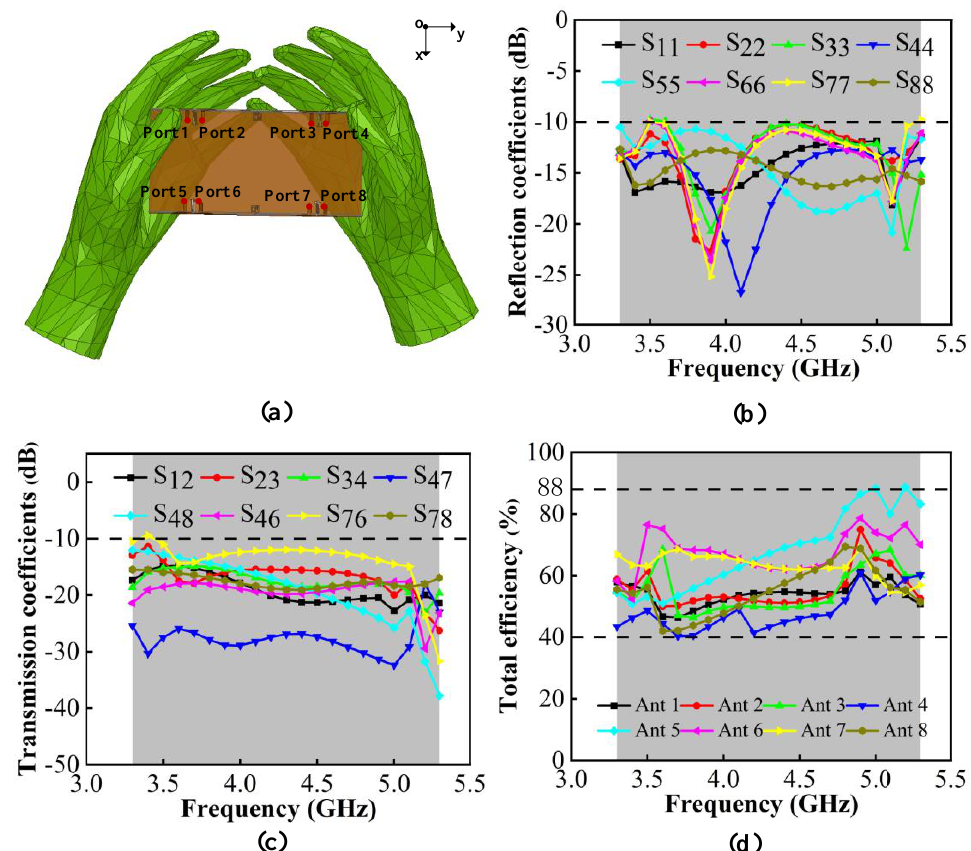
Figure 23. ( a ) MIMO system with user’s double-handed model. ( b ) Simulated reflection coefficients. ( c ) Simulated transmission coefficients. ( d ) Simulated total efficiency.